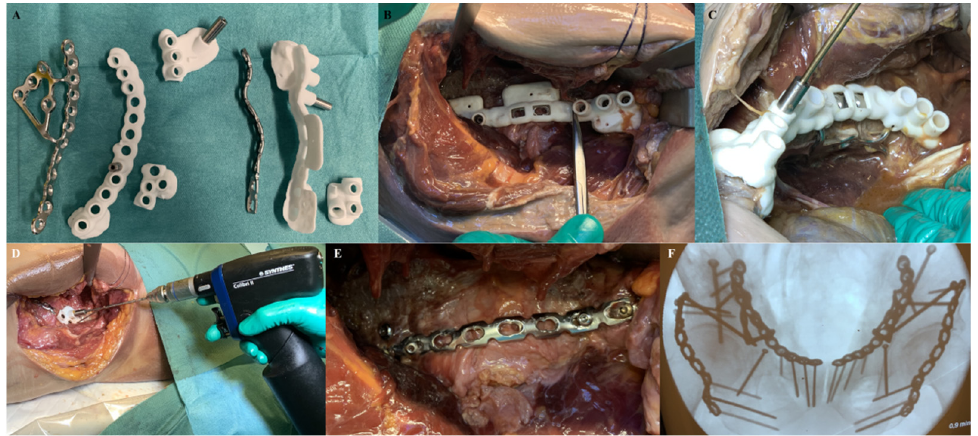
Figure 4. Surgery. ( A ) The pre-contoured implants, surgical guides including the extensions and the drill sleeves. ( B ) Perioperative view through a Kocher-Langenbeck approach with a clear view on a posterior plate with surgical guide. ( C ) Perioperative view through a modified Stoppa approach with a clear view on the suprapectineal plate with surgical guide, drill sleeve, and drill. ( D ) Fixation of the posterior plate by using a separate surgical guide with the drill sleeve and drill. ( E ) Posterior plate fixated to the pelvis. ( F ) Intraoperative fluoroscopy at the end of the surgical